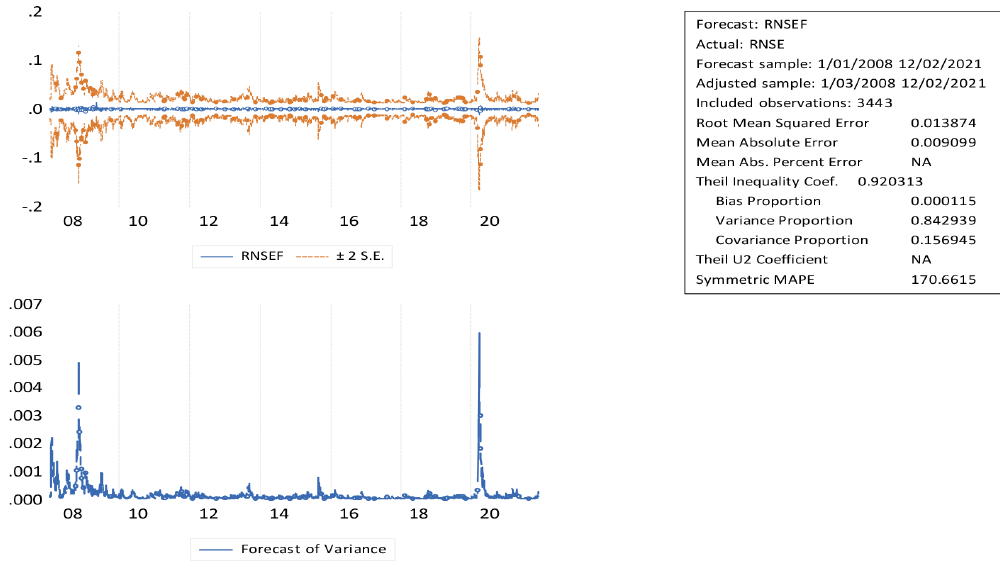
Figure 3. GARCH (1,1) NSE volatility forecasting and horizons (source: author ’ s calculations). GARCH: general- ized autoregressive conditional heteroskedasticity; NSE: National Stock Exchange; RNSE: returns of National Stock Exchange.